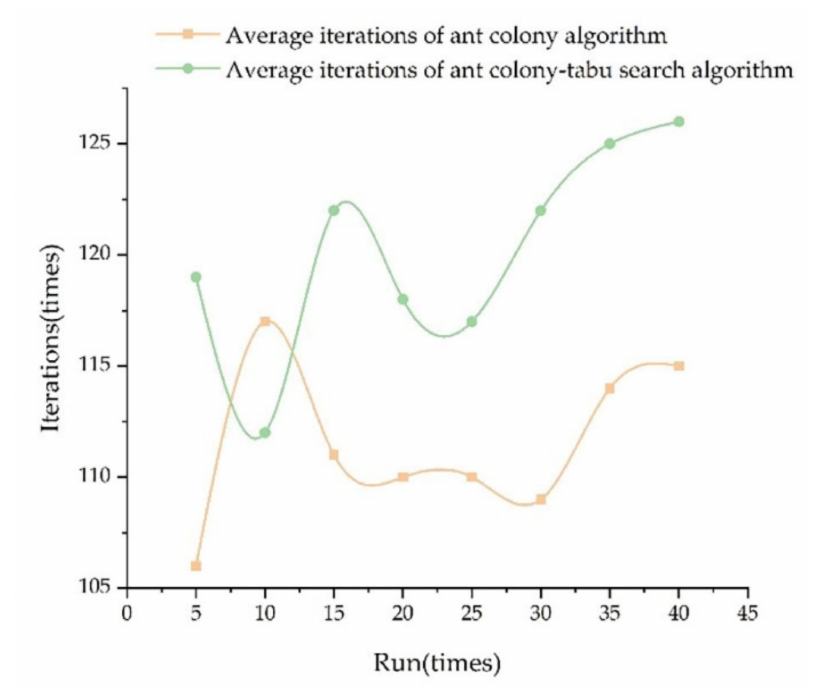
Figure 5. Comparison of average iteration times of two algorithms. Table 7. Location-routing result.